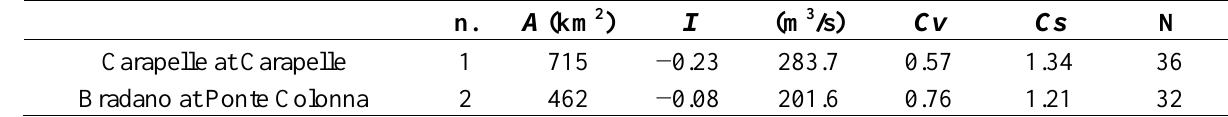
Table 1. River Basin